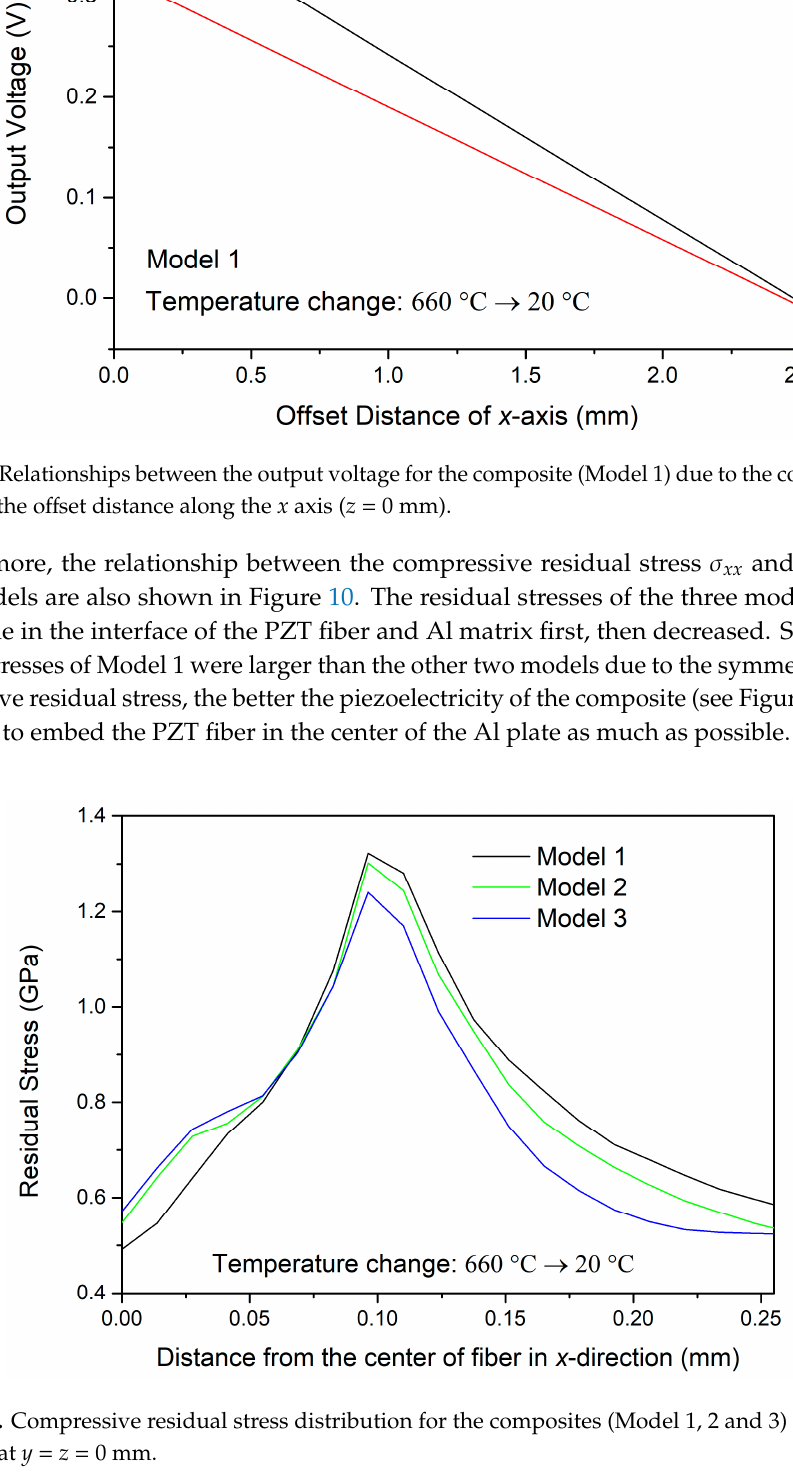
Figure 8. Relationships between the output voltage for the composite (Model 1) due to the concentrated load and the offset distance along the z axis ( x = 0 mm).